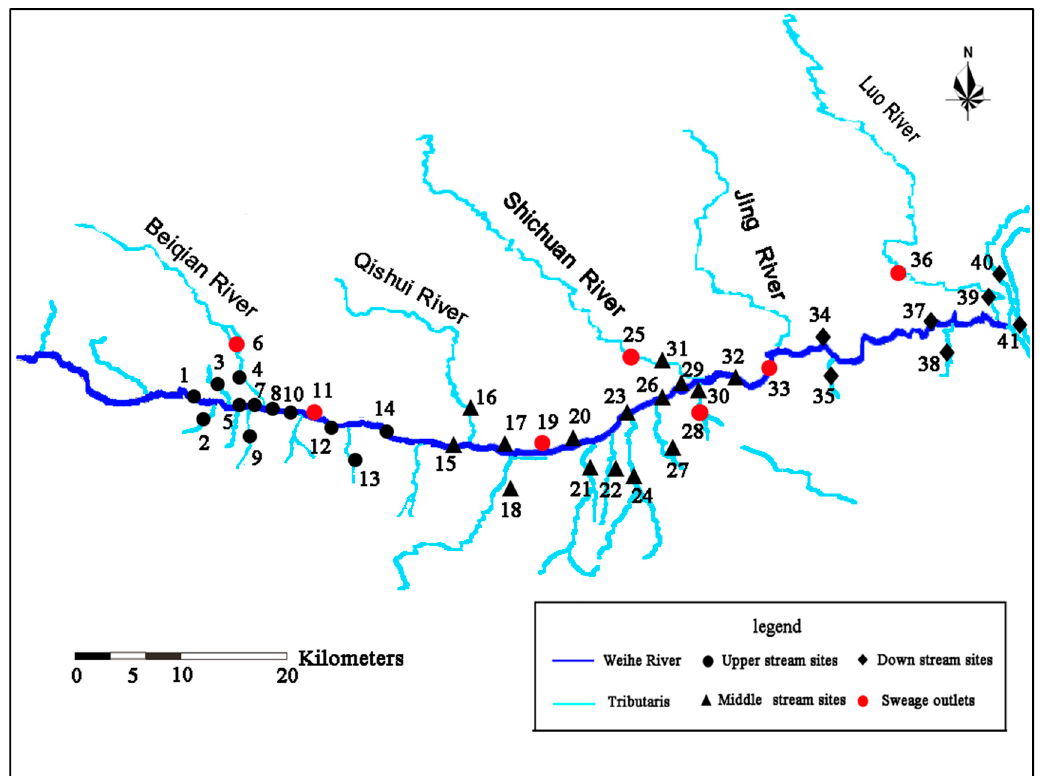
Figure 1. Sampling sites of the Weihe River (water samples and sediment samples for 1–41).